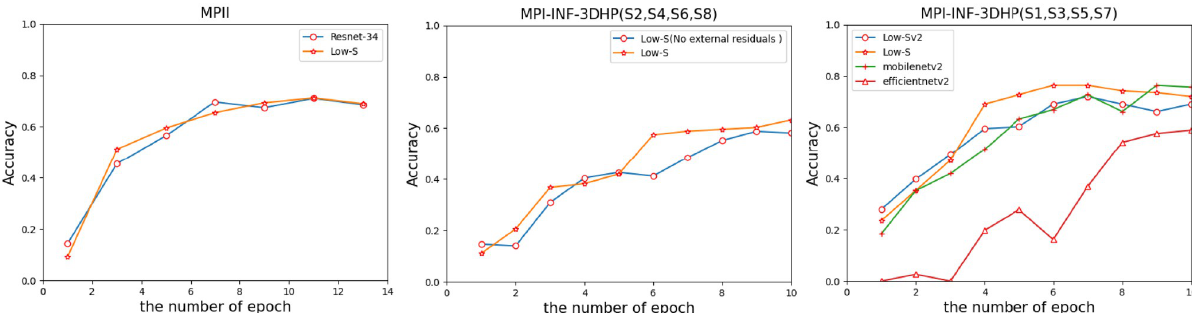
Fig 7. Comparative experiment results of Low-S, Low-Sv1, Low-Sv2 and other deep networks.